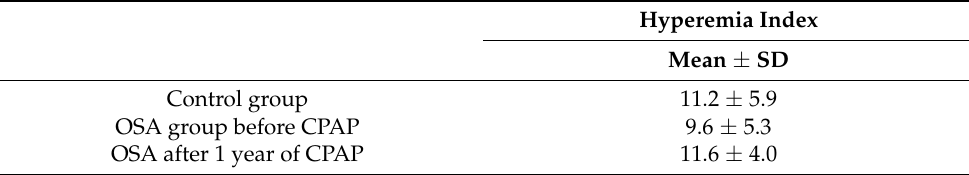
Table 2. Assessment of endothelial function by laser-doppler-flowmetry